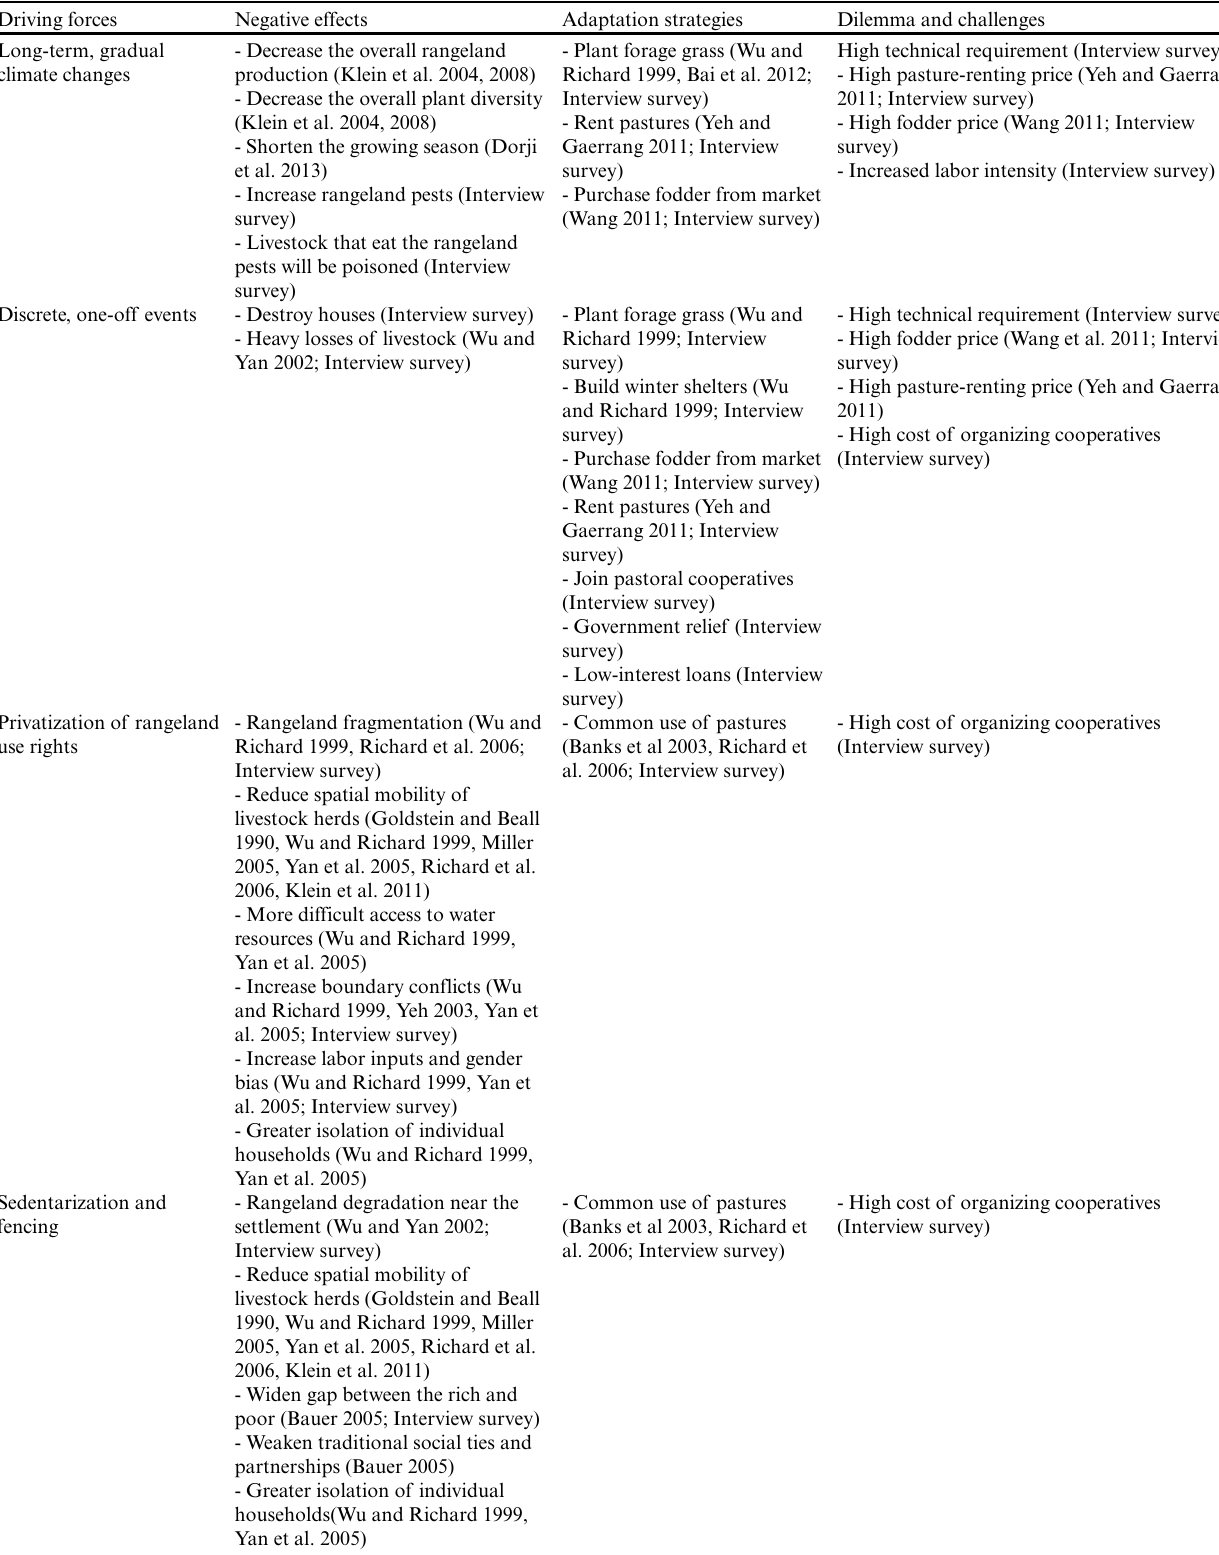
Table 8 . Factors and interactions that determine the vulnerability of the Tibetan pastoral